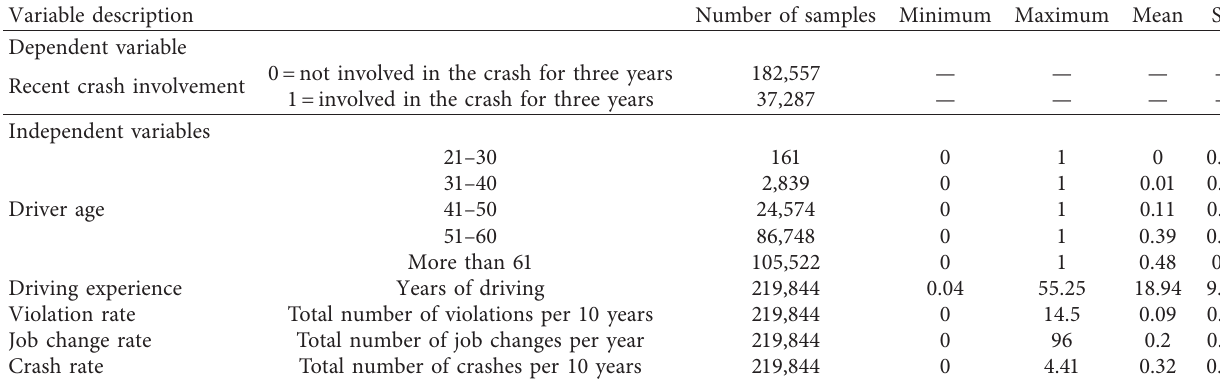
Table 3: Descriptive statistics of variables for